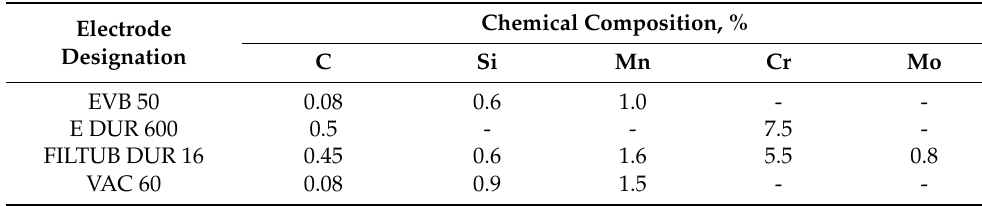
Table 6. Chemical composition of the tested filler metals.